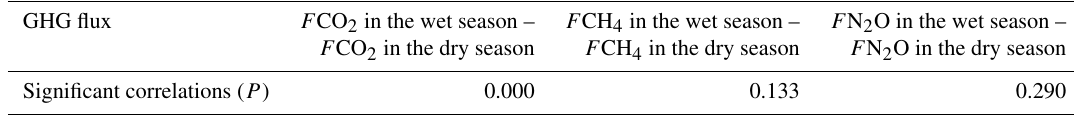
Table 3. Significant correlations between GHGs fluxes and two seasons ( n =